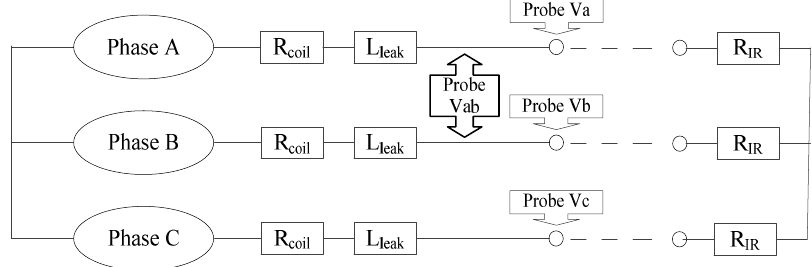
Figure 12. Coupling circuit diagram.